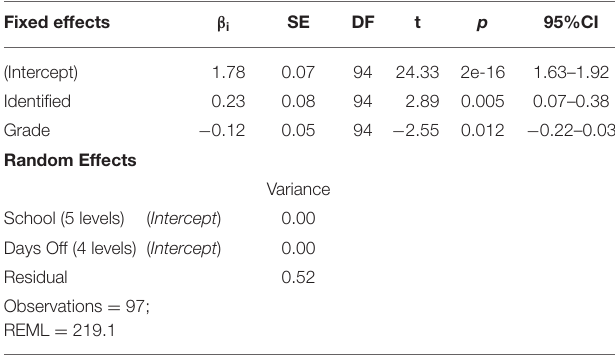
TABLE 3 | Linear mixed effects model of time spent on math homework in N = 97 middle school students tested during the COVID-19 lockdown with schools closed.